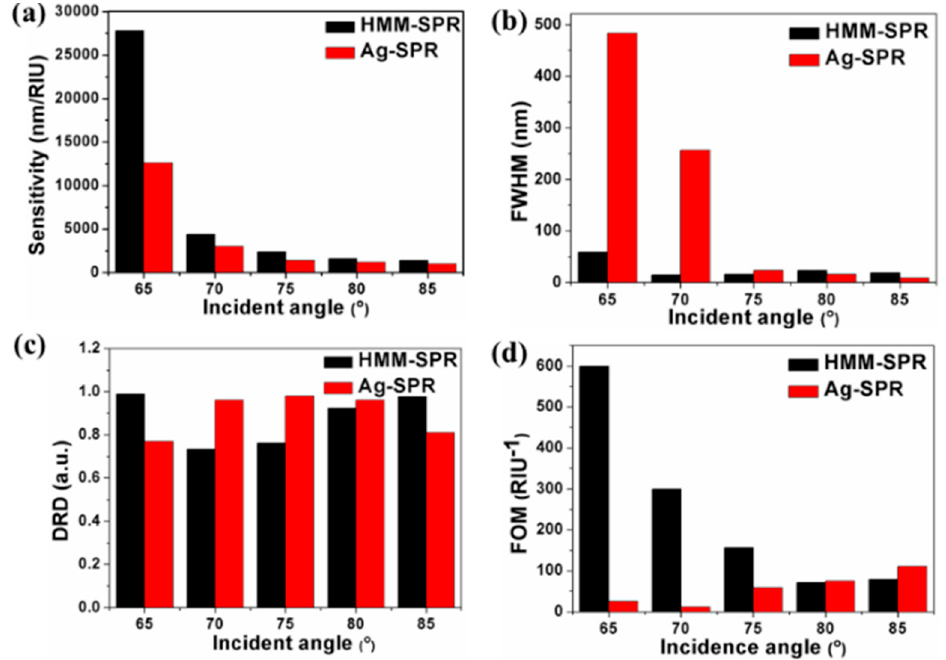
Figure 5. ( a ) S, ( b ) FWHM, ( c ) DRD and ( d ) FOM distributions with the incidence angle for the HMM-SPR and Ag-SPR sensors, respectively.